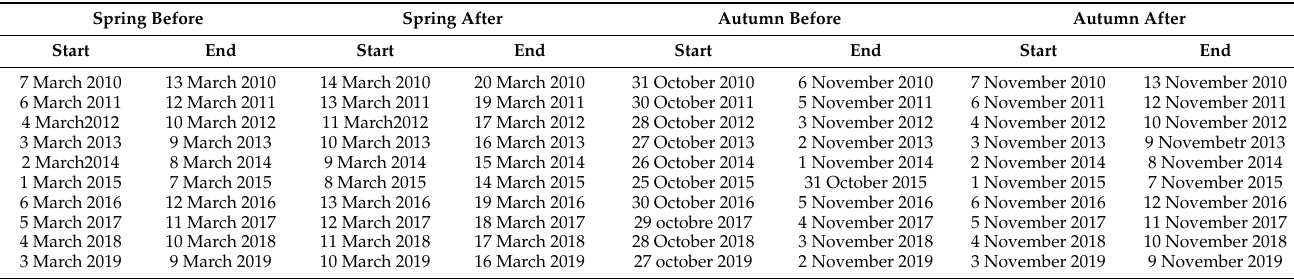
Table 1. The weeks before and after the Spring and Autumn clock change for the years 2010 to 2019 for Austin, Chicago and Louisville.